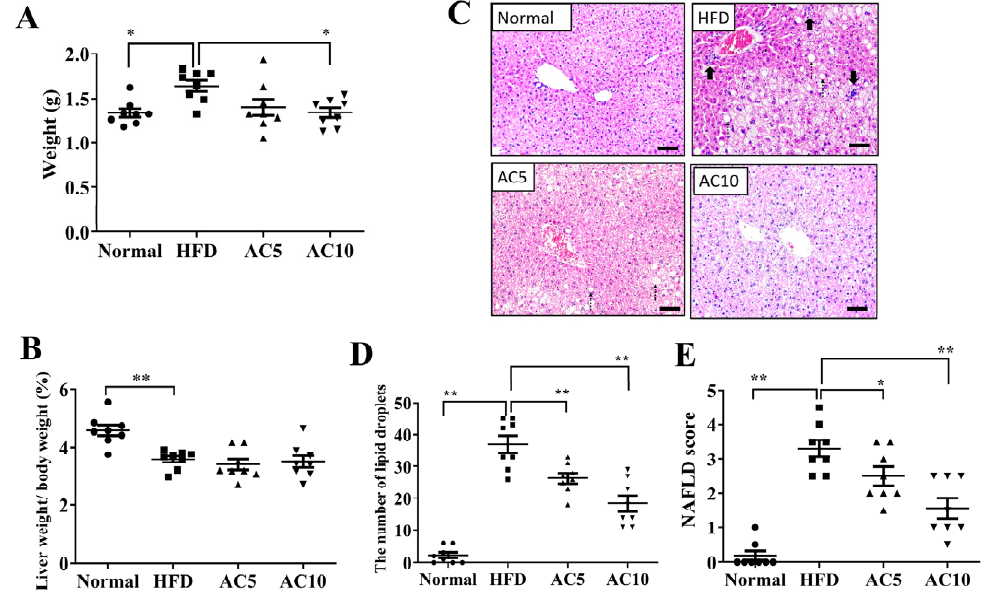
Figure 2. Biometrics of NAFLD in mice treated with acacetin (AC). ( A ) Liver weight. ( B ) the ratio of liver weight to body weight. ( C ) HE staining of liver tissues (200× magnification). ( D ) Number of lipid vacuoles in liver tissues. ( E ) NAFLD scores in liver tissues. Values are presented as mean ± SEM ( n = 8 per group). * p < 0.05, ** p < 0.01 indicate significant differences compared to obese mice. (scale bar = 100 µm; bold arrow: lobular inflammation (macrophage aggregation); dotted line arrow: ballooning).